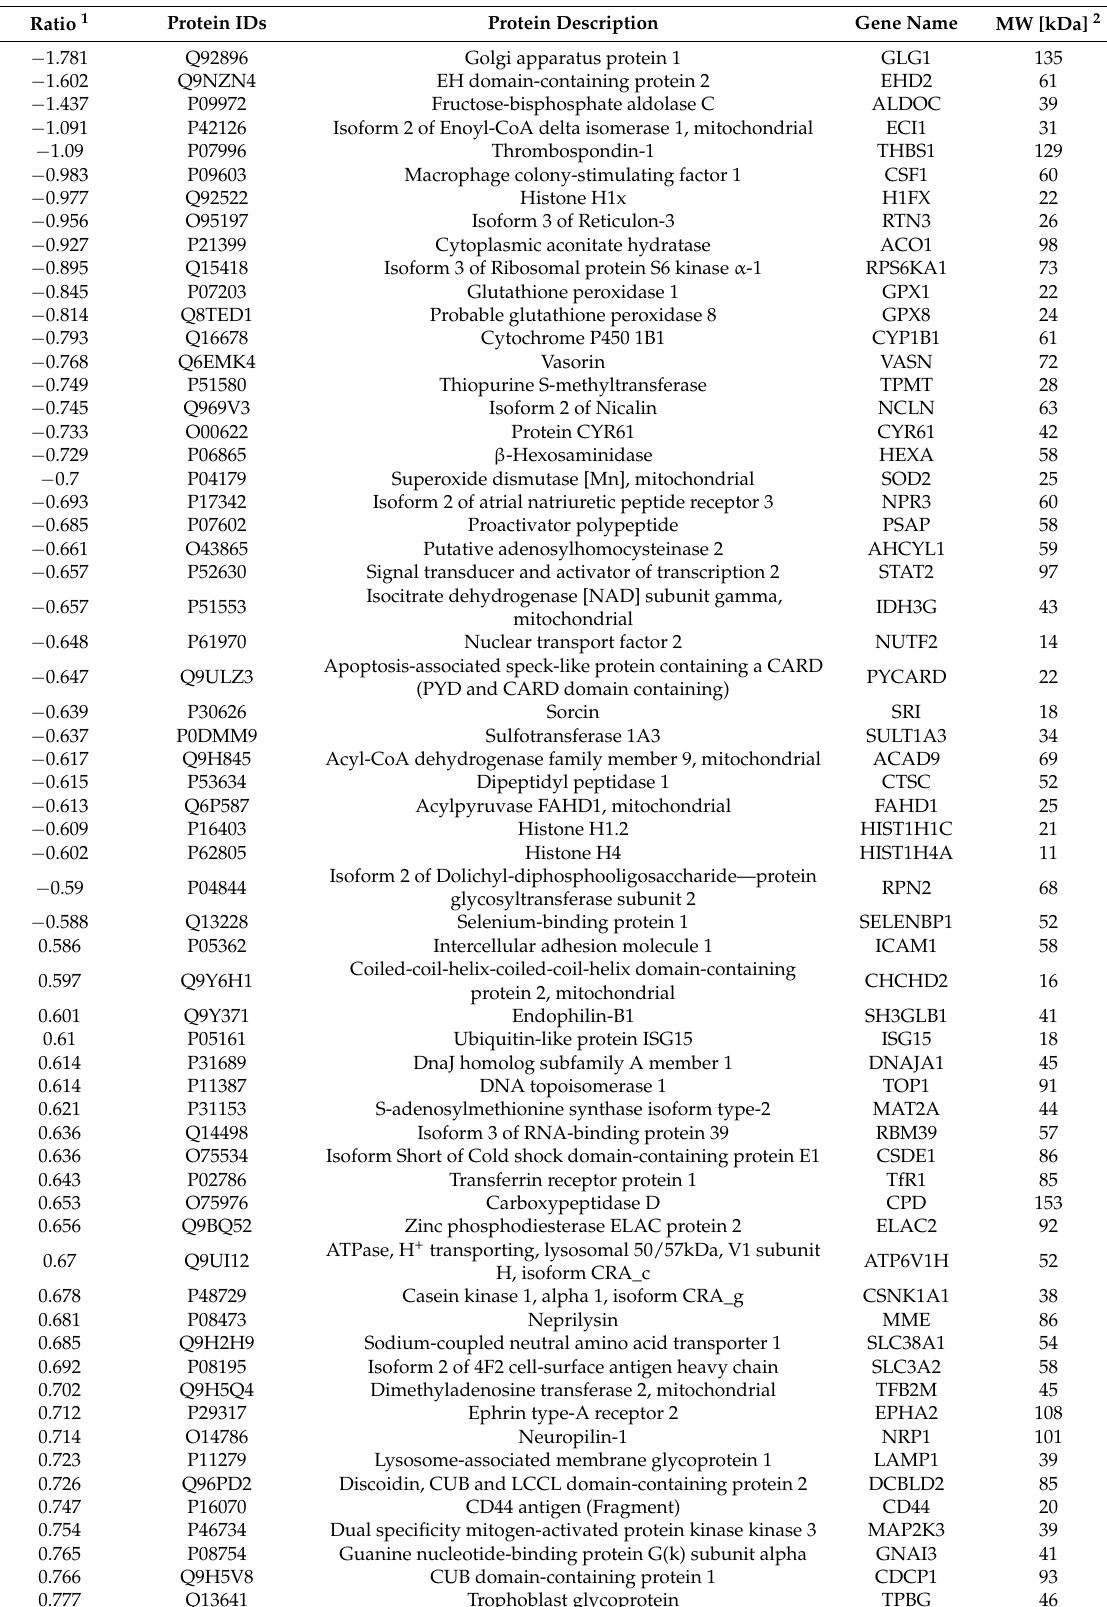
Table 1. Proteins differentially expressed in response to iron overload in HH4